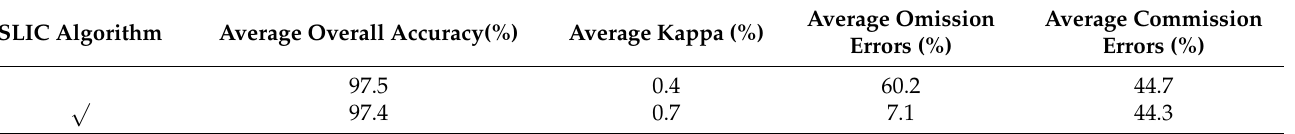
Figure 19. Comparison of dam segmentation without and with the SLIC algorithm. ( a ) Original im- ages; ( b ) dam detection results; ( c ) dam segmentation results without the SLIC algorithm; ( d ) dam segmentation results with the SLIC algorithm. 4.3. Comparison of Dam Extraction Results with Open Dam Datasets